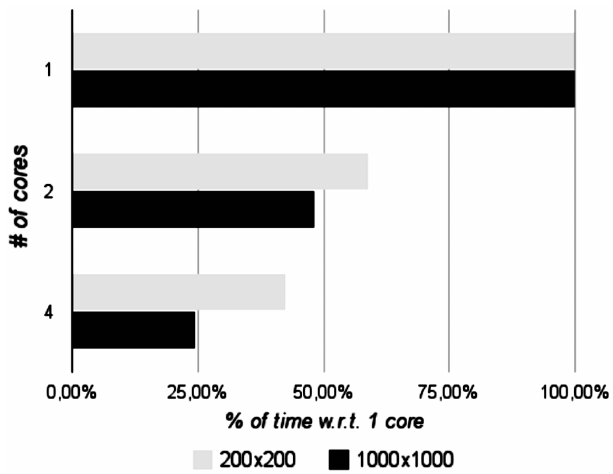
Fig. 2. Performance improvement with multi-core imple- mentation.